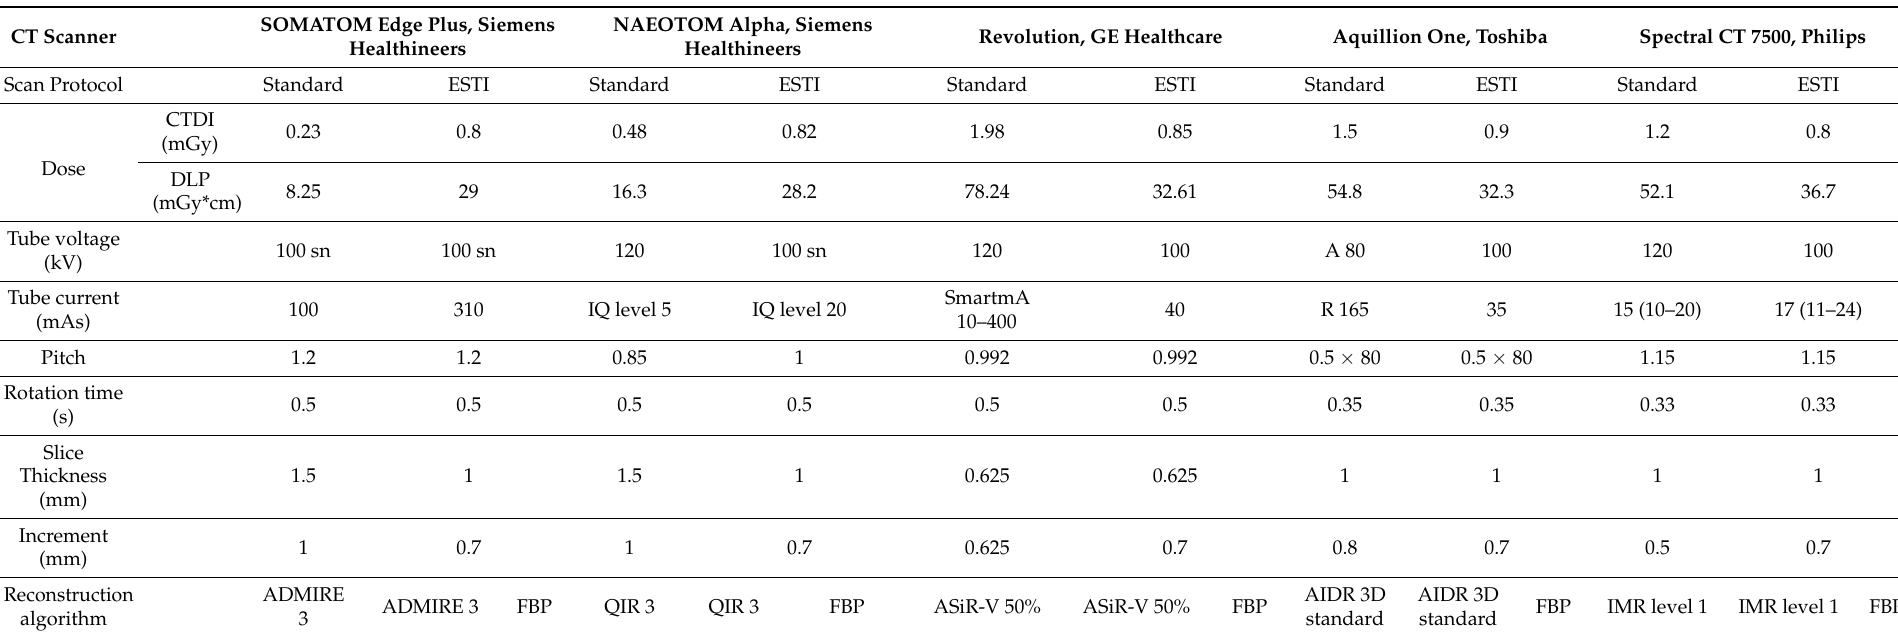
Table 1. Scanning Protocols. The tube current of the NAEOTOM scanner was modulated by adjusting the system’s image quality (IQ) setting. The standard protocol of GE’s Revolution CT scanner used a rotational automated exposure control program named SmartmA. The standard protocol used by Toshiba’s Aquillion One and an automated exposure control program designated by the letters “A” and “R”. CTDI: Computed tomography dose index; DLP: Dose length product; 100 sn: 100 kV with tin filtration; ADMIRE: Advanced Modeled Iterative Reconstruction; QIR: Quantum Iterative Reconstruction; ASiR: Adaptive Statistical Iterative Reconstruction; AIDR: Adaptive Iterative Dose Reduction; IMR: Iterative Model Reconstruction. Filtered Back Projection